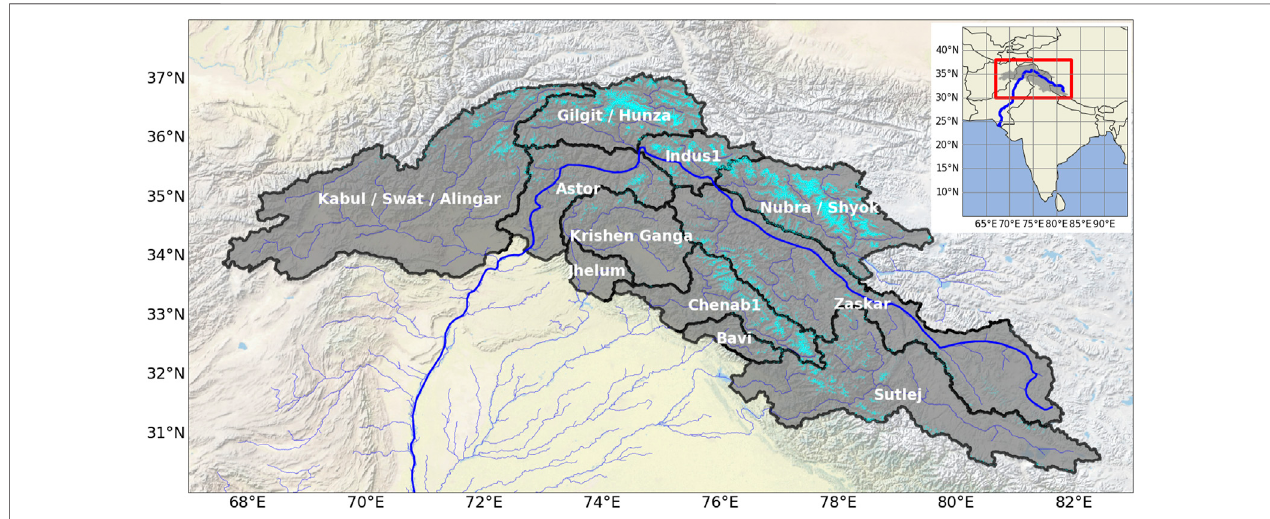
FIGURE 1 | The upper Indus Basin (dark gray shading; Wijngaard et al., 2017) divided into the 11 subbasins used in this study (bold black polygon outlines; Immerzeel et al., 2020), shown with glaciers (cyan; RGI Consortium, 2017) and river tributaries (blue; FAO, 2021) to the main stem of the Indus (bold blue; Alexander, 2021). This map has a WGS84 projection. Map baselayer from ESRI with digital layer from National Geographic (2011).